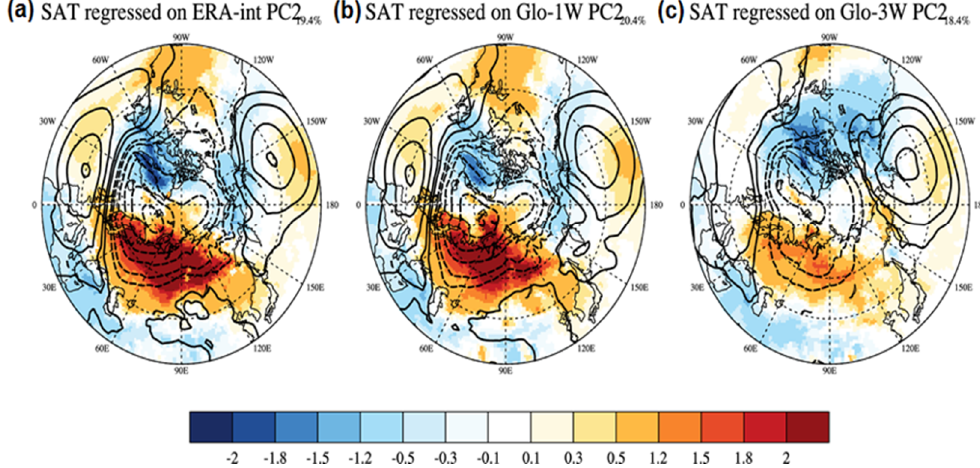
Figure 8. Surface temperature (shaded) and sea level pressure (contours) regressed onto the EOF 2nd PC from ( a ) ERA–Interim, ( b ) GloSea5 with a lead time of 1 week, and ( c ) GloSea5 with a lead time of 2 weeks.